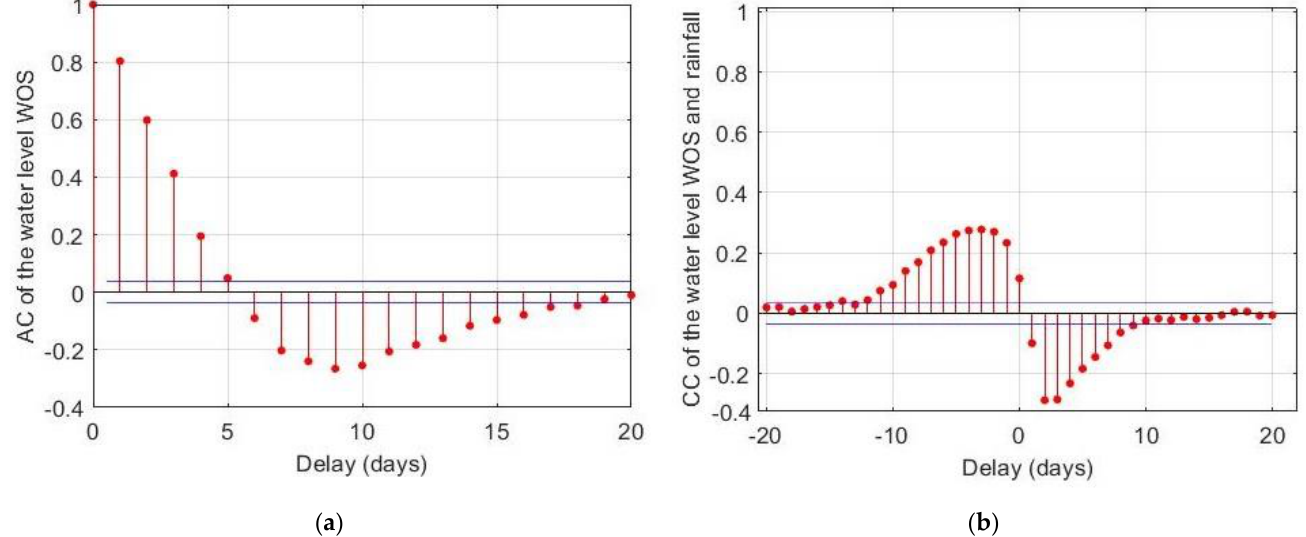
Figure 6. Water level autocorrelation ( a ) and cross-correlation of precipitation ( b ). Symbology: AC = Autocorrelation, WOS = without seasonality, CC = cross-correlation.